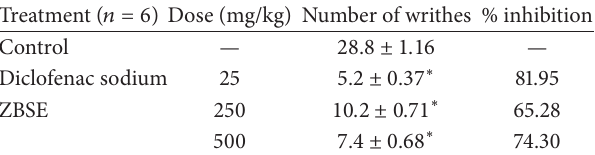
Table 4: Effect of Z . budrunga seed extract on acetic acid induced writhing in